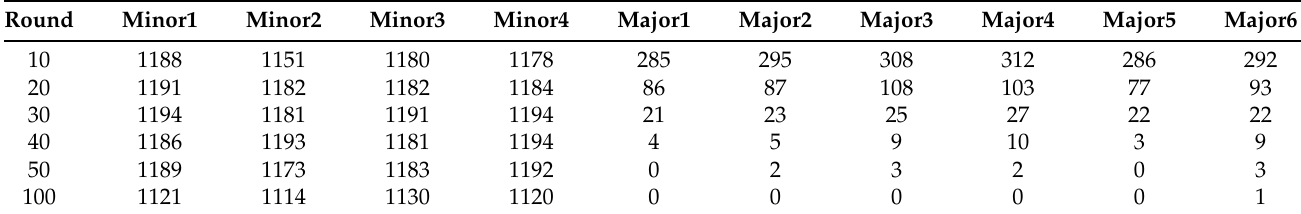
Table 3. Forgettable example counts in each client when non-IID